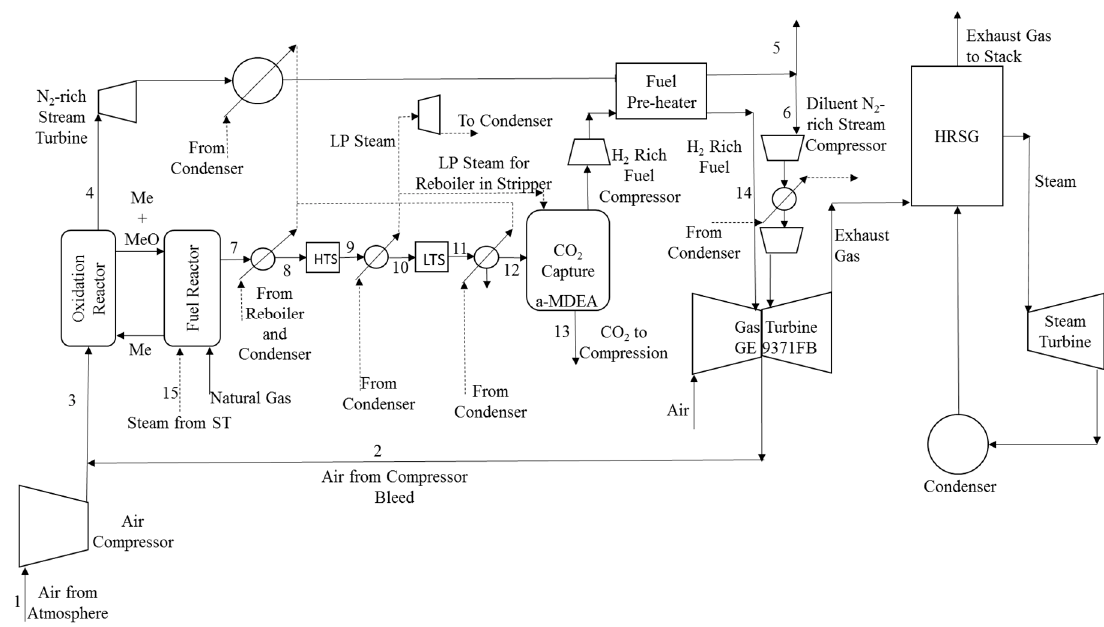
Figure 2. Schematic of the CLR-CC process.